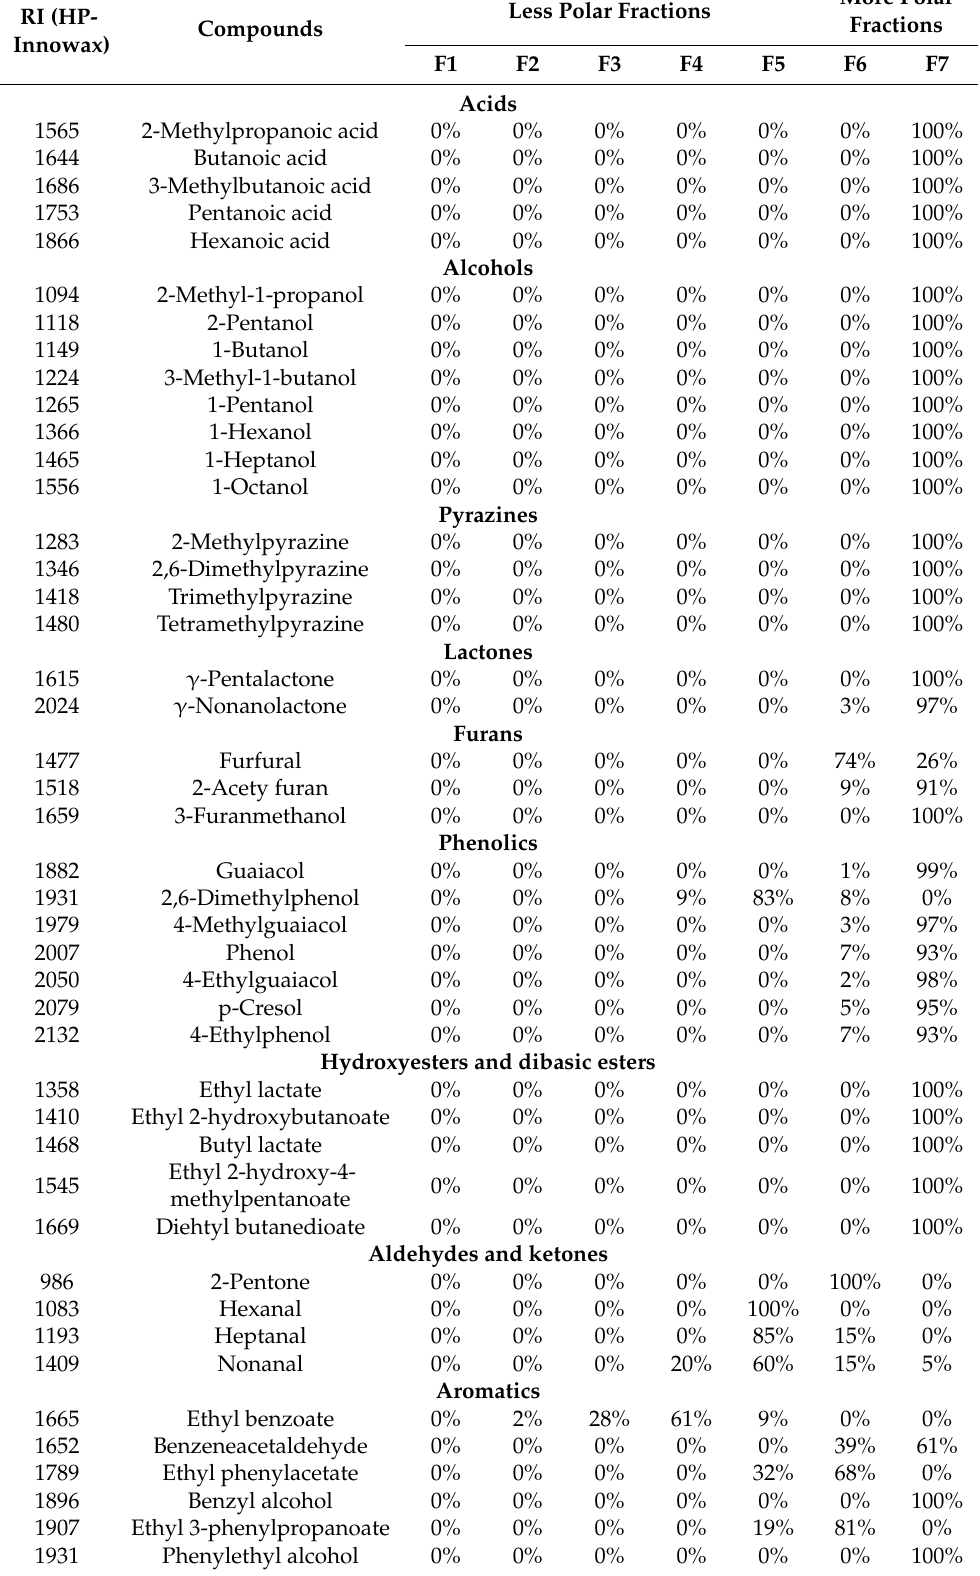
Table 3. Other volatile distributions (as a percent of the total elution) in different